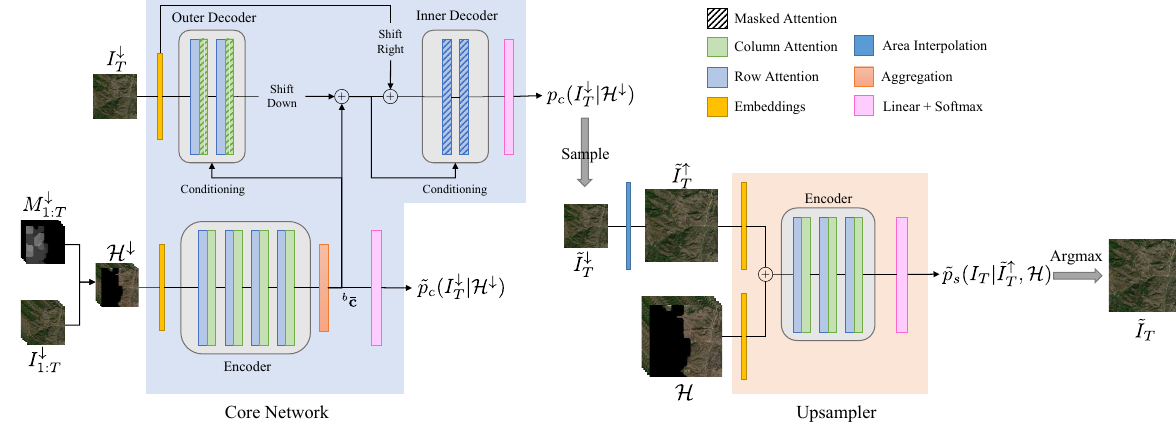
Figure 1. Proposed